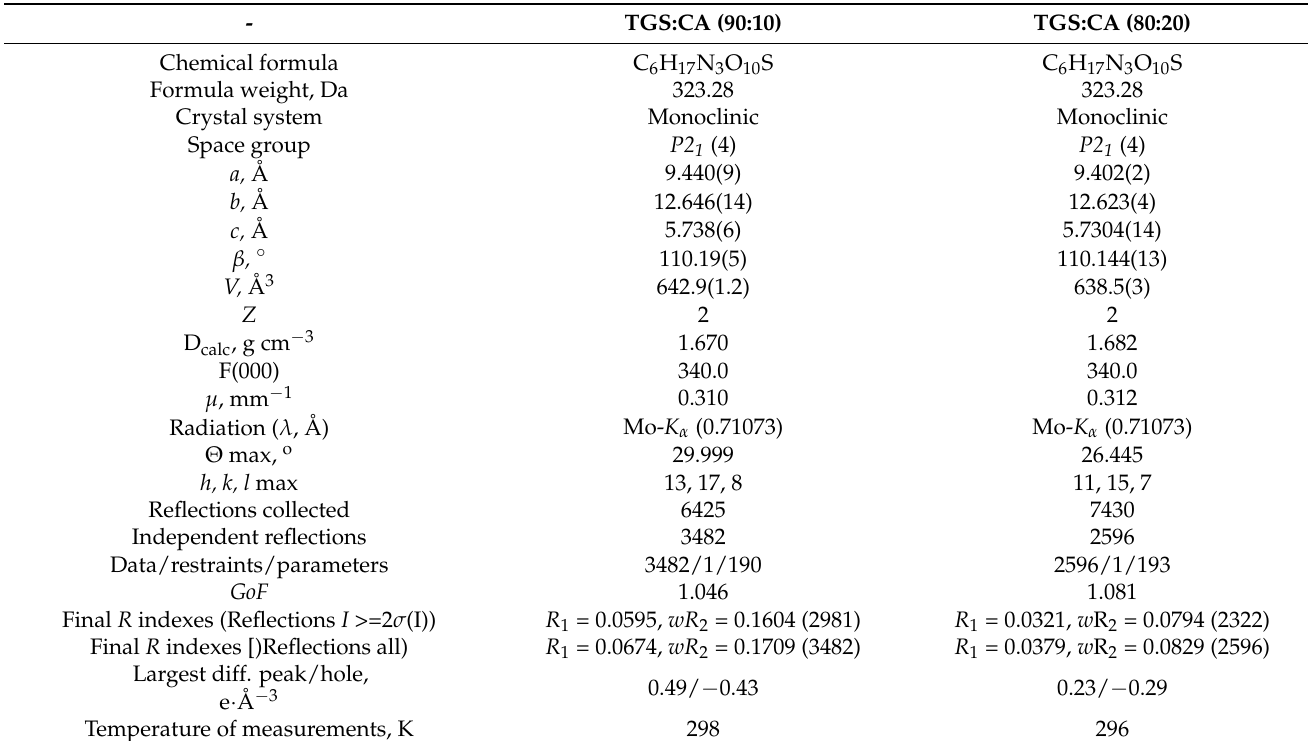
Table 1. Details of crystal data and structure refinement of single